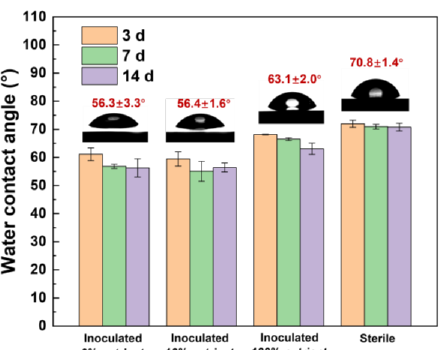
Figure 6. Water contact angle values of the coating surfaces after 3, 7, and 14 days of immersion in the sterile culture medium and inoculated culture media with 100%, 10%, and 0% nutrients. The insets are the morphologies of water droplets on coating surfaces after 14 days of